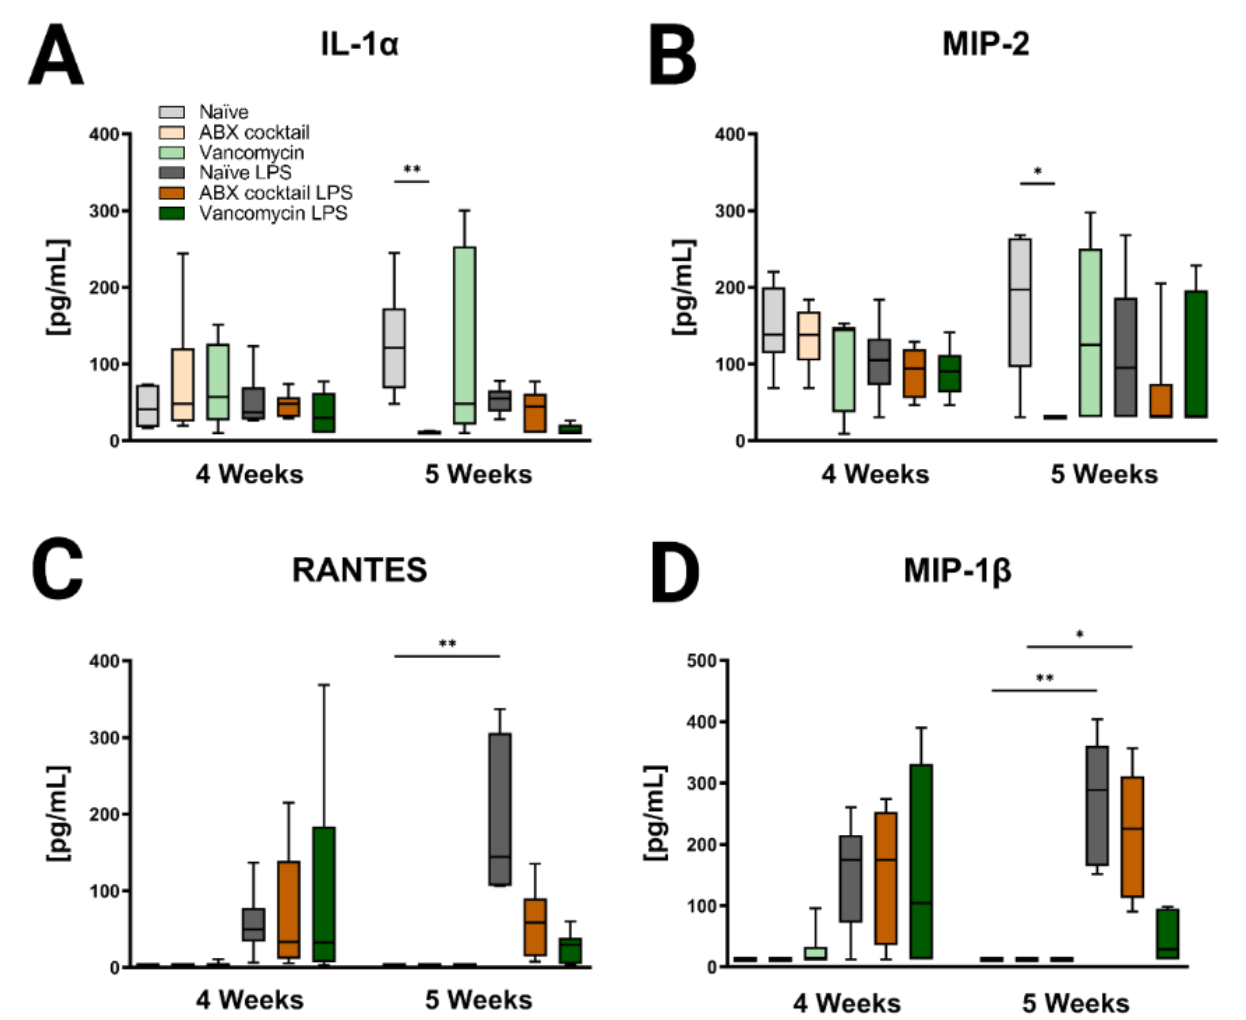
Figure 5. Inducible serum cytokines and chemokines are affected by maternal ABX treatment. The data represents the responses of ( A ) IL-1 α , ( B ) MIP-2, also known as CXCL2, ( C ) RANTES, also known as CCL5, and ( D ) MIP-1 β , also known as CCL4 at 4 and 5 weeks. Naïve = light grey, ABX cocktail = light brown, Vancomycin = light green, Naïve LPS = grey, ABX cocktail LPS = brown and Vancomycin LPS = green. n = 6 for all groups. Kruskal–Wallis with Dunn’s multiple comparison test. Values represent median + interquartile range means ± SEM, * p ≤ 0.05, ** p ≤ 0.01.